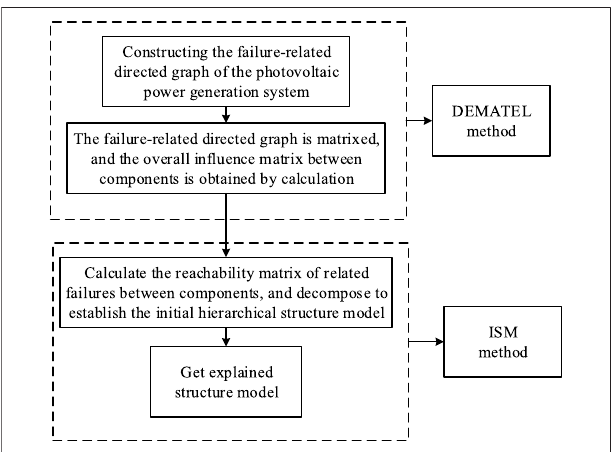
FIGURE 2 | Block diagram of failure correlation.